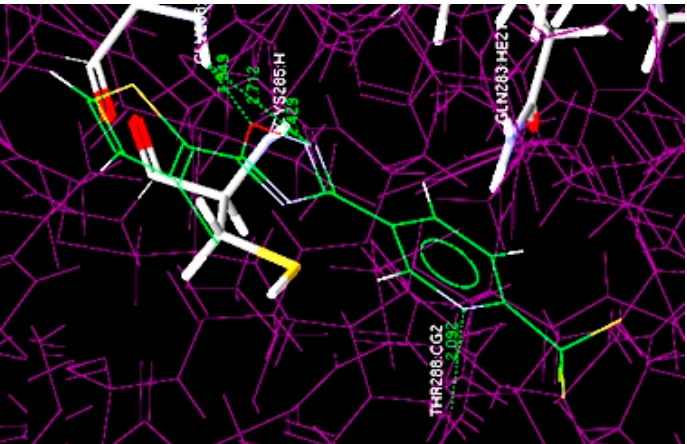
Figure 2. Correlation of experimental and predicted activity in 2D QSAR model. Table 4. Experimental, predicted and residual activities of the compounds obtained in 2D QSAR and GOLD score. 2D QSAR All 28, 1,2,4-oxadiazoles derivatives were docked into the binding site of caspase-3 Comp.